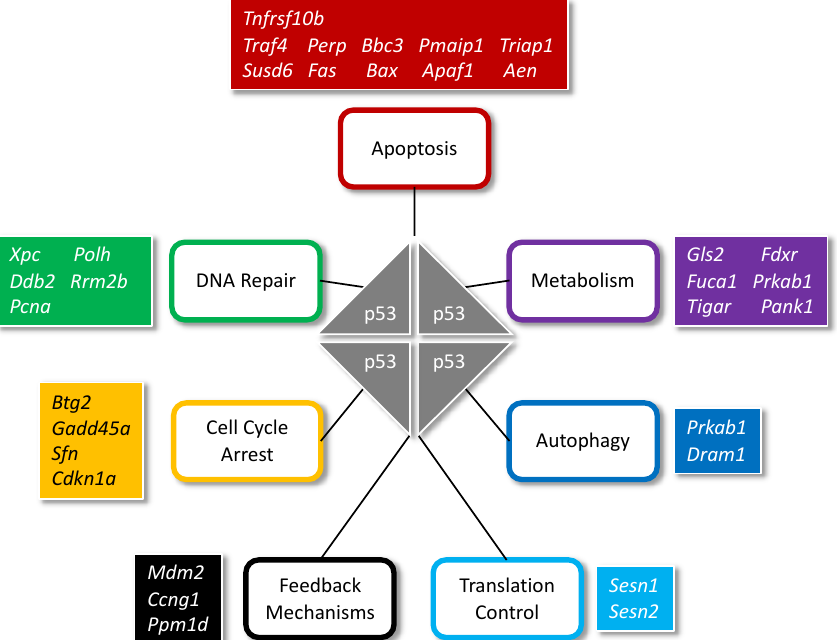
Figure 1. High confidence p53 target genes and the functions they facilitate . p53 binds to DNA as a homotetramer. Examples of proteins encoded by p53 target genes function in multiple processes include, but are not limited to, cell cycle arrest, DNA repair, apoptosis, metabolism, autophagy, translation control and feedback mechanisms. Adapted from [32] with permission from Oncogene journal, 2017. Symbols are from the HUGO gene nomenclature committee (https://www.genenames.org/ accessed on 20 October 2021).